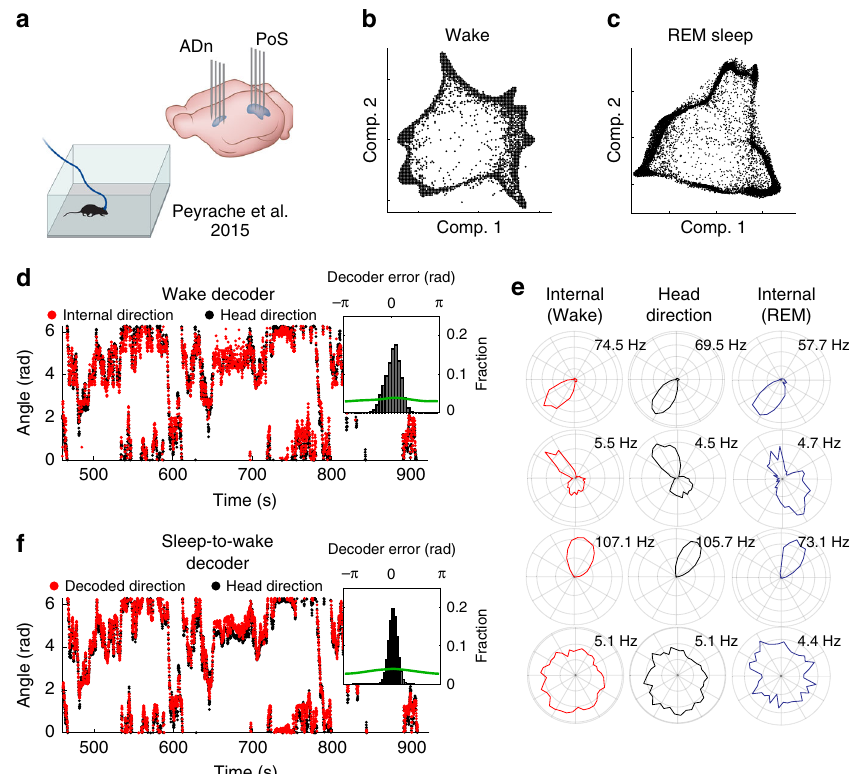
Fig. 4 Internal representation of head direction during wake and REM-sleep periods. a Data were obtained from dense electrophysiological recordings from the ADn and PoS of mice foraging for food in open environments 29 . b , c The distribution of data points in the reduced dimensional space of neuronal activity exposes a ring topology during wake periods ( b ) and during periods of REM sleep ( c ). Each data point corresponds to the neuronal activity within a single time frame. d The reconstructed internal direction (red) and the actual head direction (black). Inset, distribution of the error in the reconstruction of head direction (black) versus shuf fl ed data (green). e The internal tuning curve, relative to the state of the network (left, red), the external head-direction tuning curve, relative to mouse behavior (center, black), and the internal tuning curves during periods of REM sleep (right, blue) for four representative cells. f The decoded head direction (red) and the actual head direction (black). Inset, distribution of the decoding error (black) versus shuf fl ed data (green). The decoder is based on internal tuning curves obtained exclusively from